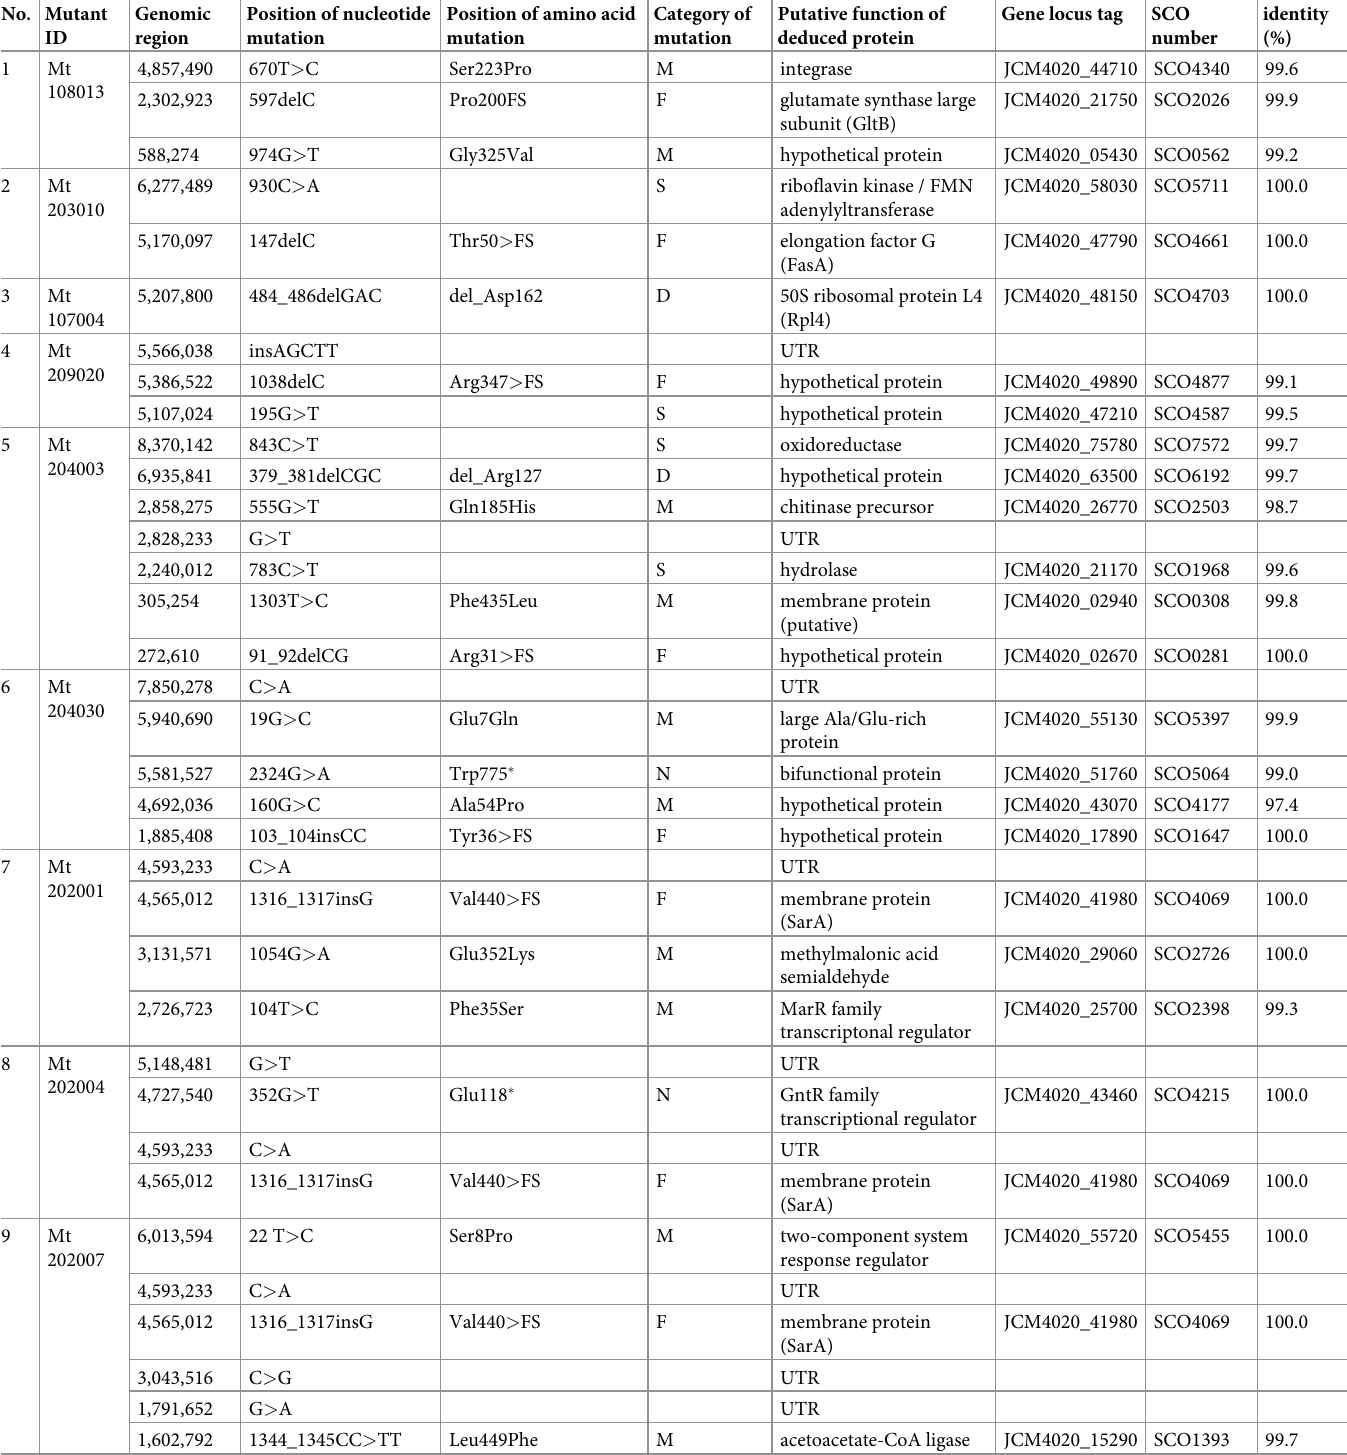
Table 2. Point mutations found in the RED production-deficient mutants of S . coelicolor JCM4020. No. Mutant